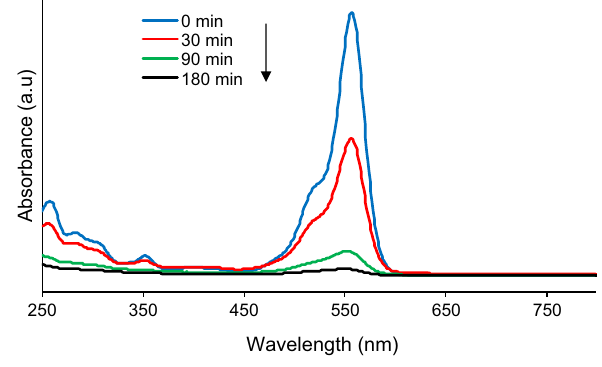
Fig. 11 Repeated recycling of AC@Fe/3 (0.27 g/L) with H (8 mM) for the degradation of Rhodamine B (50 mg/L) (pH = 4.2, Temperature = 28